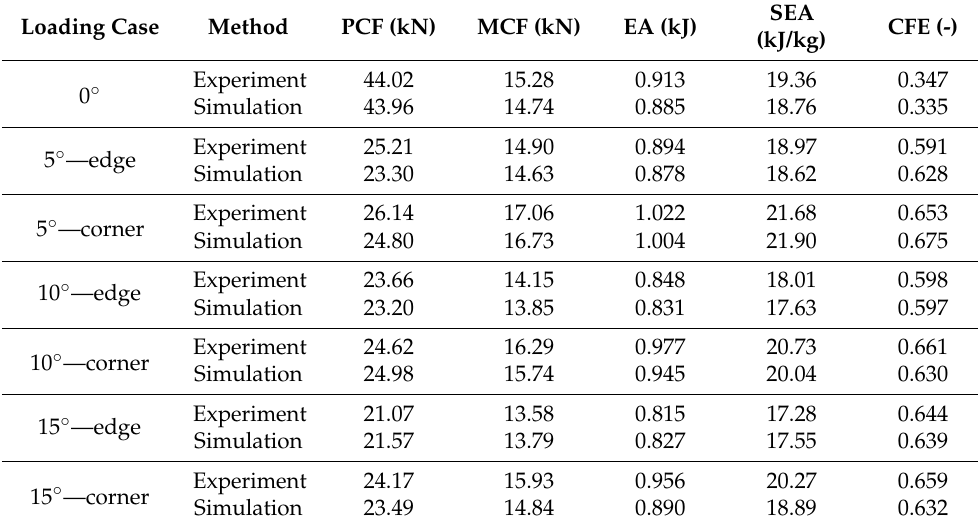
Table 3. Experimental and numerical results for crashworthiness